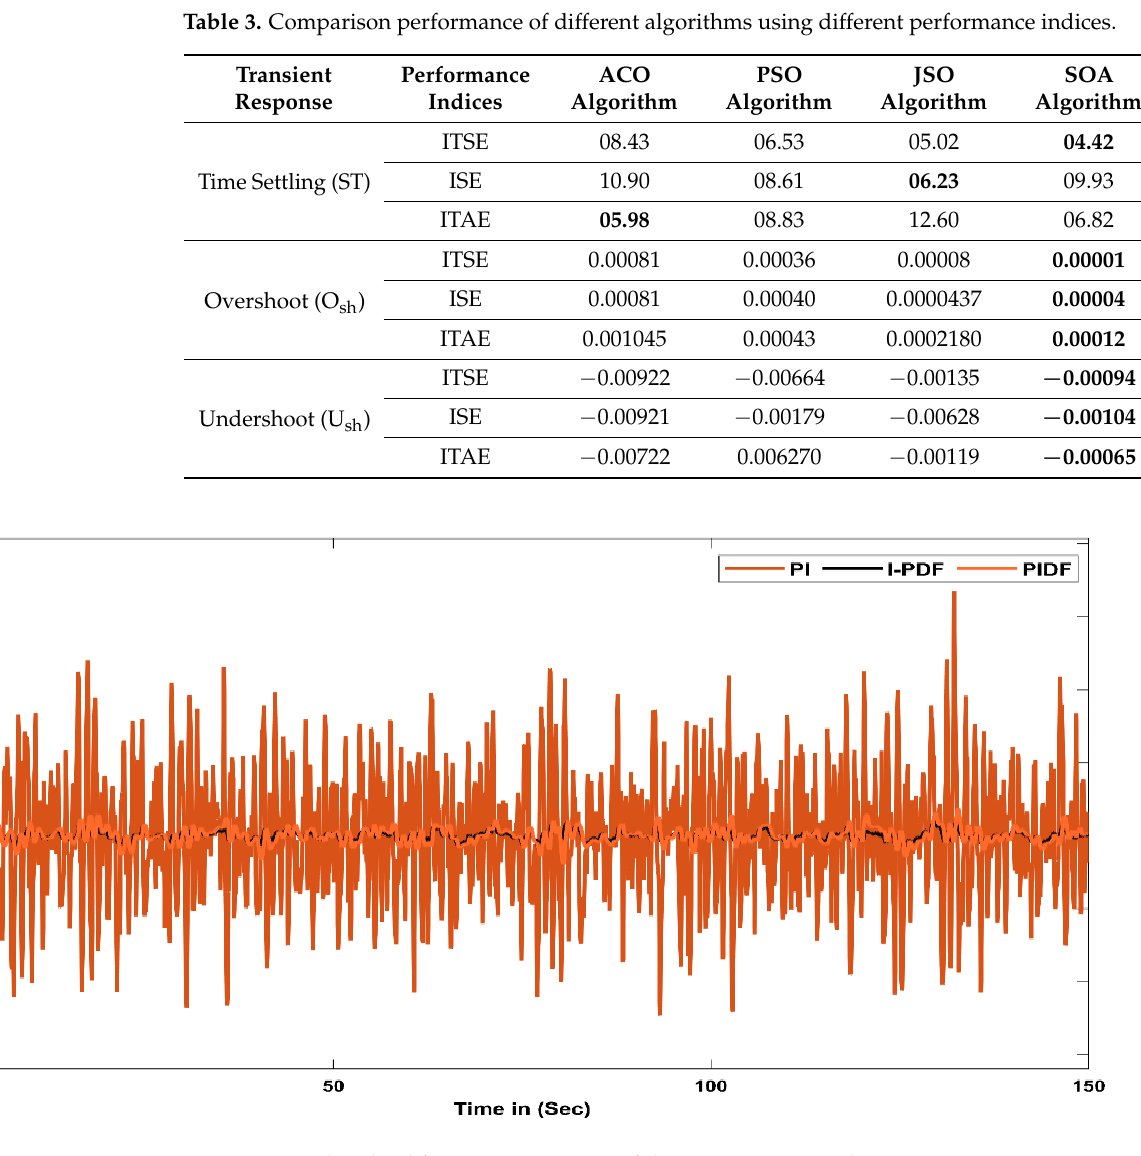
Figure 9. Load variation for the marine microgrid system from ±25% to ±50%.